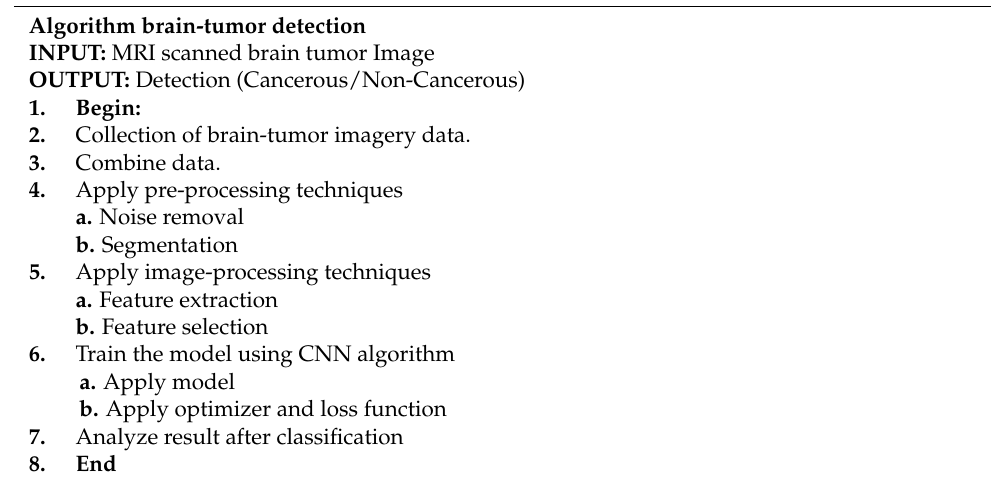
Algorithm 1: Proposed methodology algorithm Algorithm brain-tumor